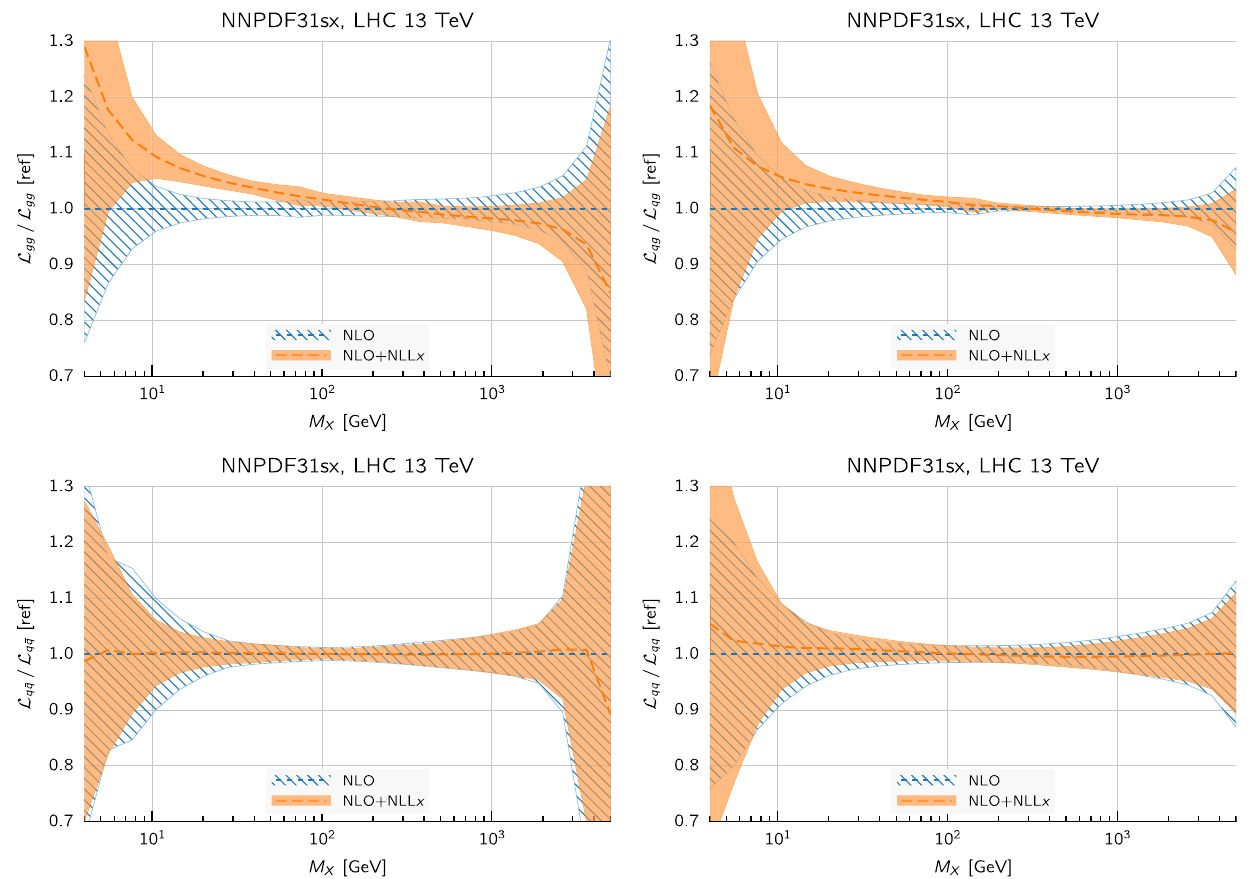
Fig. 30 Same as Fig. 29, now comparing the results of the NLO+NLL x and NLO